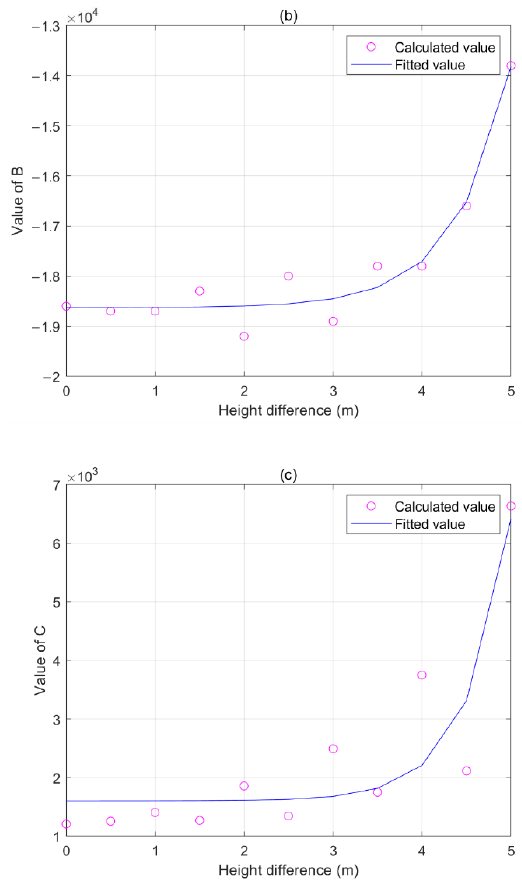
Figure 17. Effects of tower height difference on coefficients: ( a ) A of different height differences; ( b ) B of different height differences; ( c ) C of different height differences.